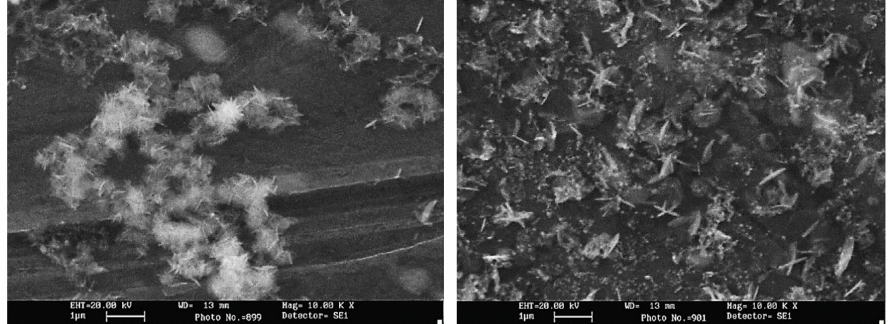
Figure 5. Scanning electron microscopy showing the morphology of ZnO nanoparticles at laser wavelengths of 532 nm (top row) and 1064 nm (bottom). Adapted with permission from Ref. [106]. Copyright 2013, Elsevier Ltd.